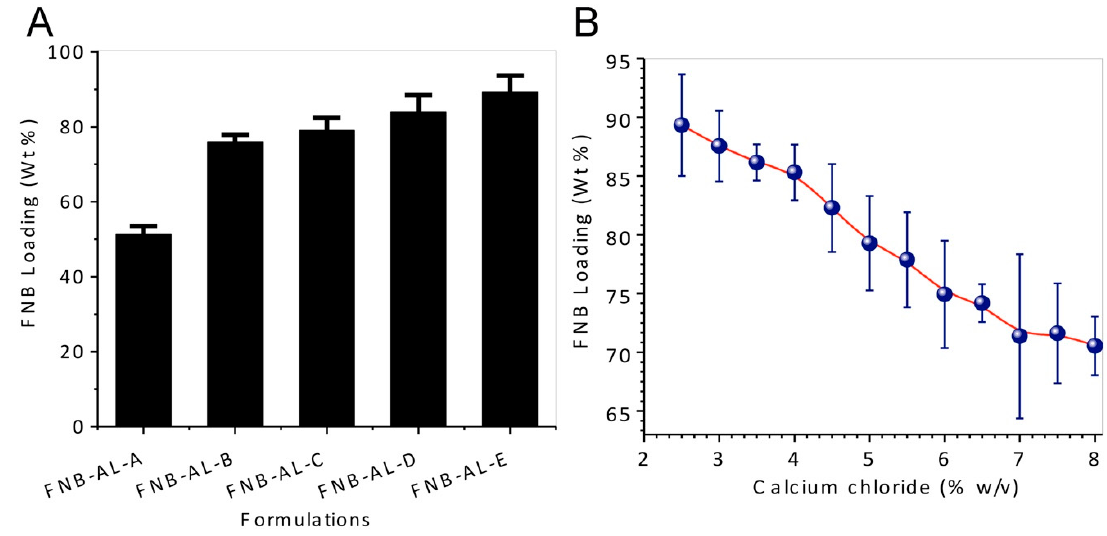
Figure 3. ( A ) Drug-loading capacity of various NCSM formulations, and ( B ) the effect of crosslinker concentration on FNB-NC loading in NCSMs.